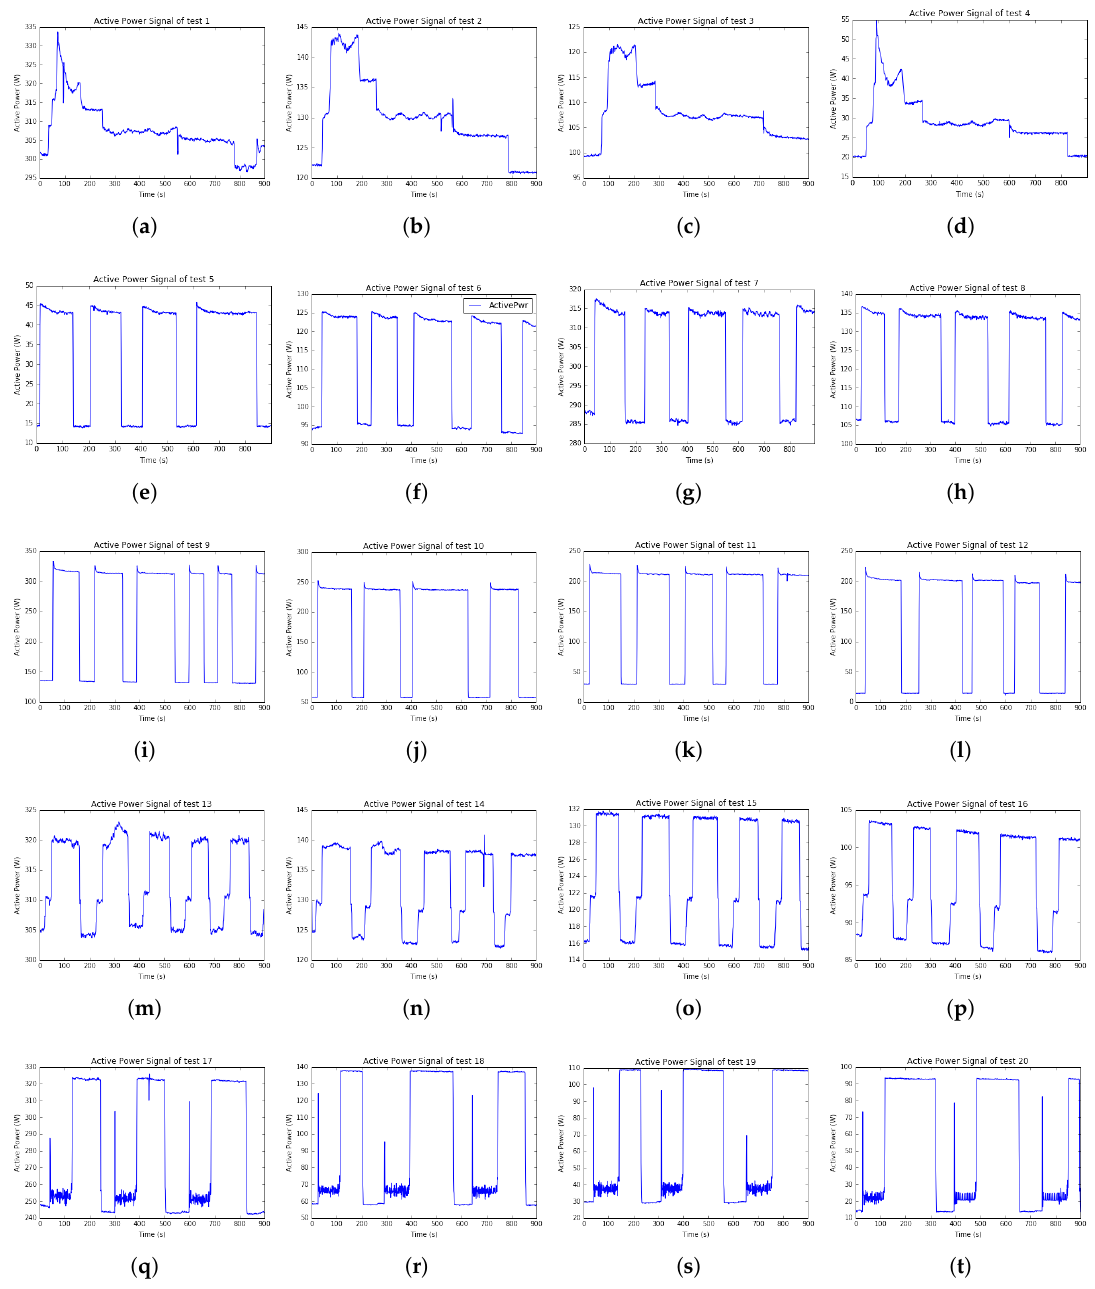
Figure 11. Active Power Signals of twenty test cases data: ( a – d ): test 1 to test 4; ( e – h ): test 5 to test 8; ( i – l ): test 9 to test 12; ( m – p ): test 13 to test 16; ( q – t ): test 17 to test